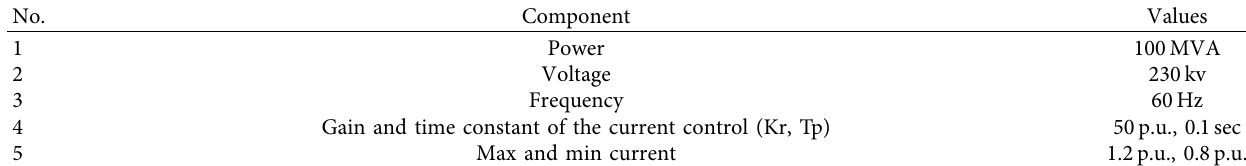
Table 6: Value of STATCOM components.